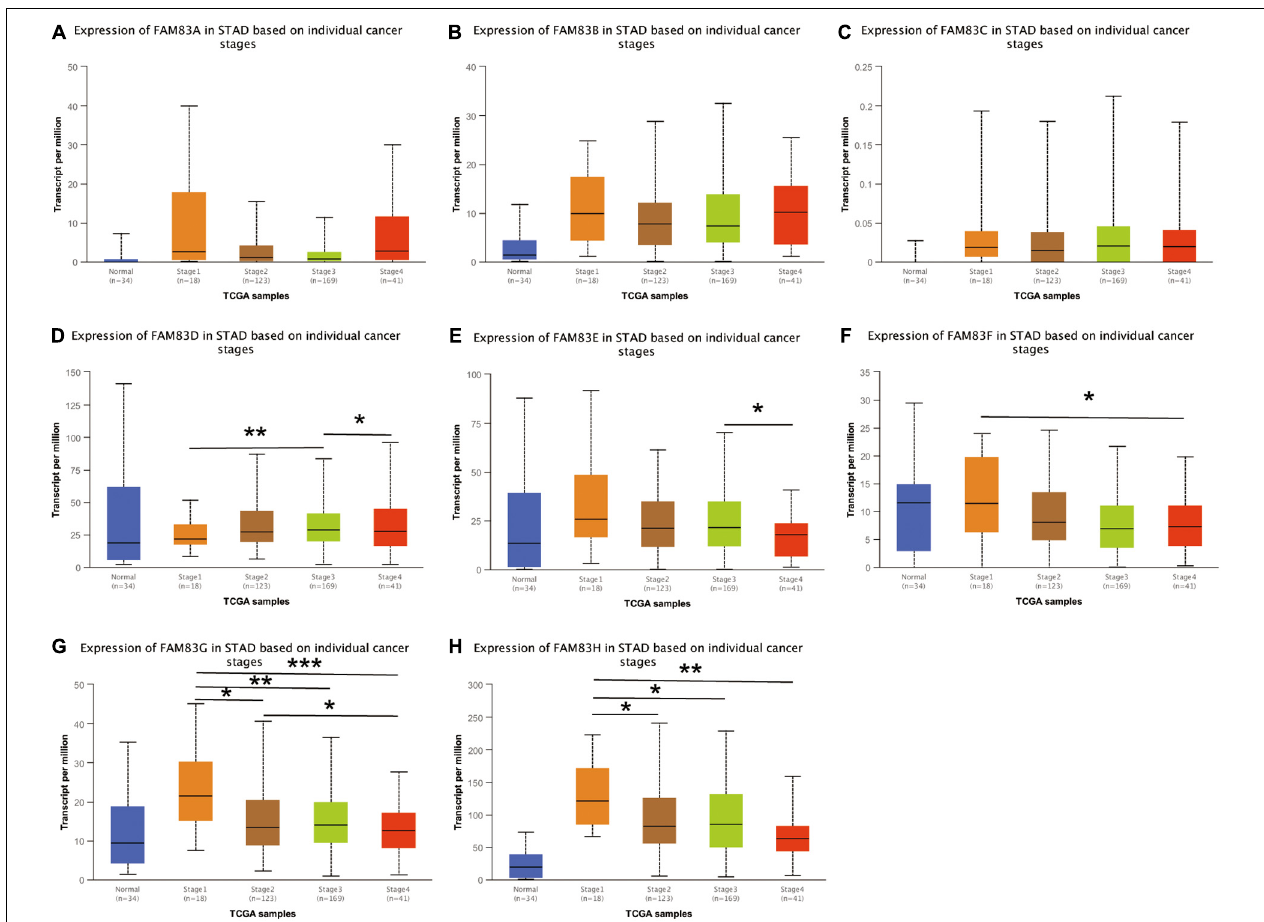
FIGURE 4 | (A–H) The correlation between mRNA expression levels of FAM83 family and individual cancer stage in STAD patients (UALCAN). FAM83D/E/F/G/H mRNA expressions were significantly related to patients’ individual cancer stage, while mRNA expressions of FAM83A/B/C were not remarkably associated with patients’ individual cancer stages. Significance of difference estimated by student’s t -test considering unequal variance. ∗ p < 0.05, ∗∗ p < 0.01 and ∗∗∗ p <